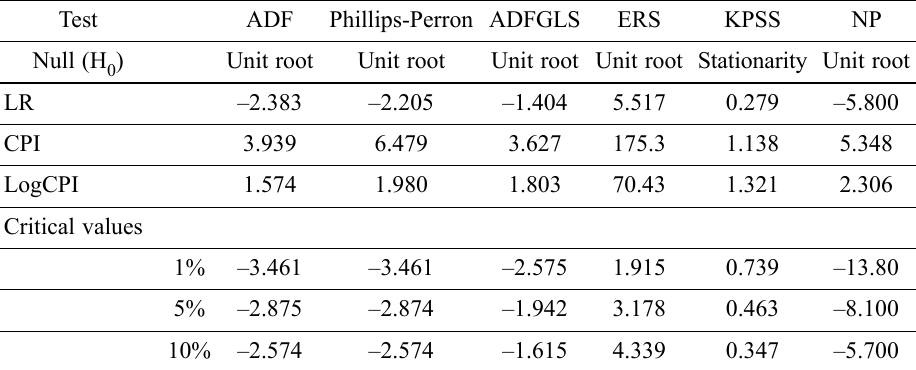
Table 4 . Stationarity test results for the series LR, CPI,